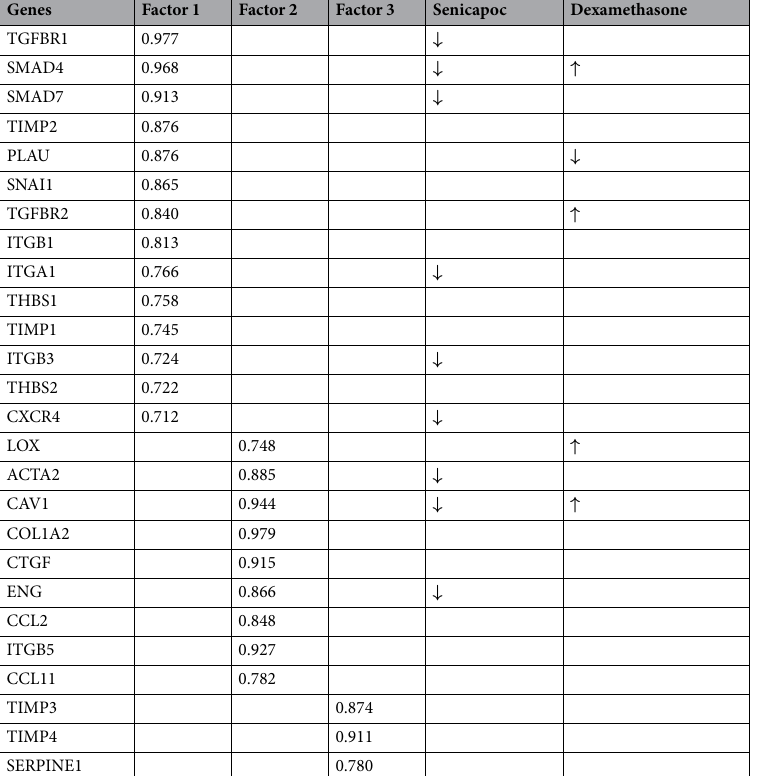
Table 1. Factor analysis of TGF β 1-dependent